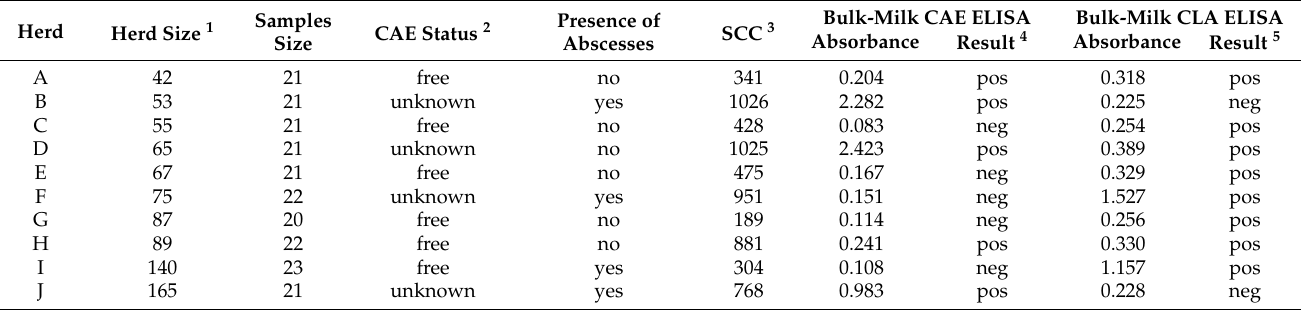
Table 1. Herd characteristics and test results of the 10 goat herds included in the study to estimate the occurrence of CAE and CLA (Sweden, 2018).